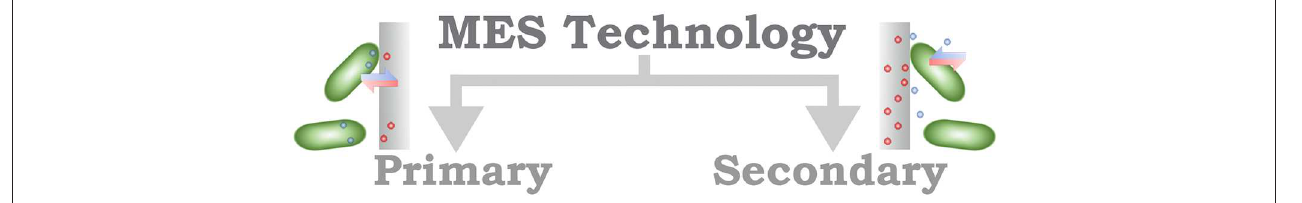
FIGURE 2 | Schematic organization of the MES classification based on the technology used in the system.